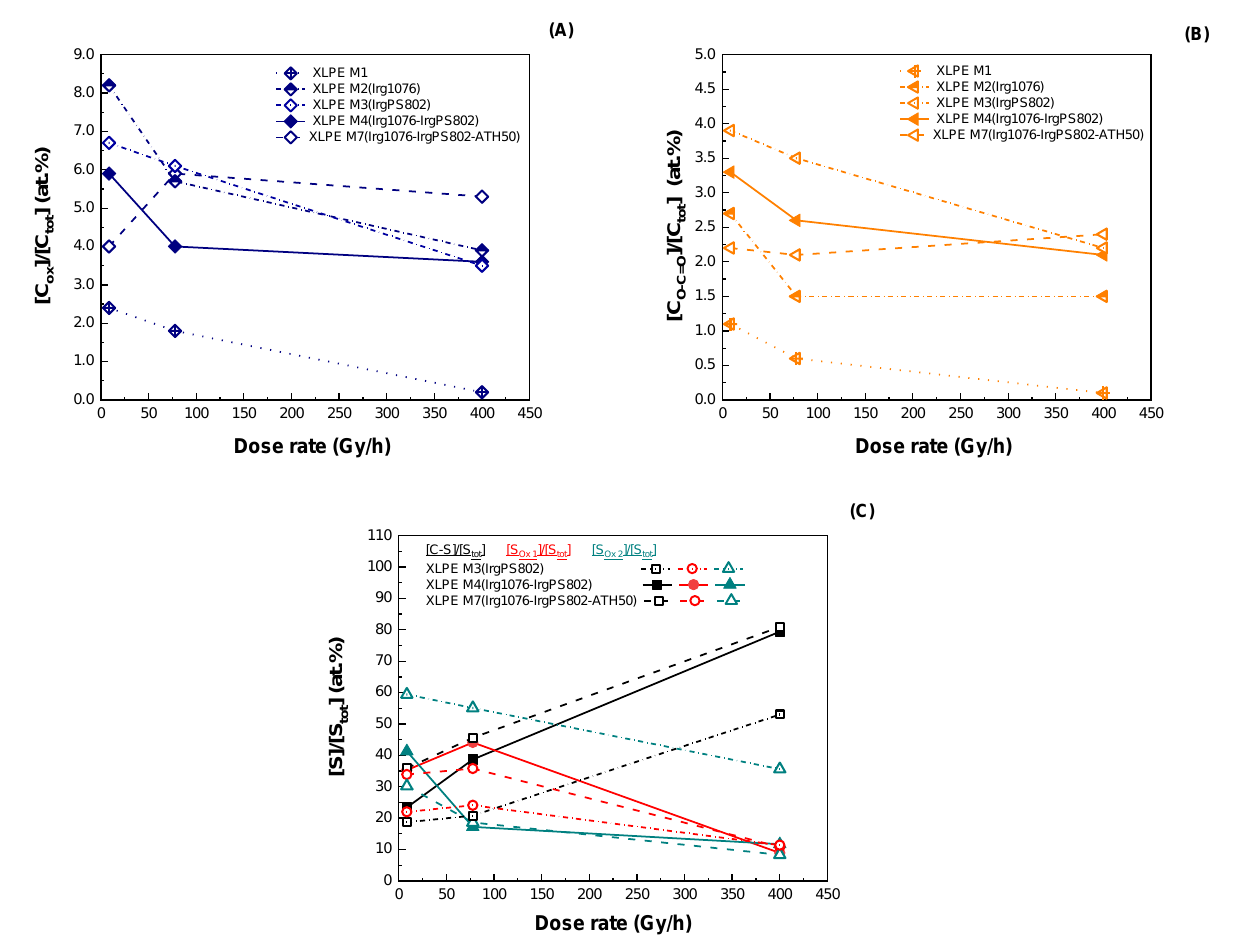
Figure 3. Evolution as a function of dose rate for XLPE M1, XLPE M2(Irg1076), XLPE M3(IrgPS802), XLPE M4(Irg1076-IrgPS802) and XLPE M7(Irg1076-IrgPS802-ATH50) of ( A ) C ox , which refers to all oxidised carbon atoms (i.e., O- C =O, C -O and C =O) and of ( B ) O- C =O. Evolution as a function of dose rate for XLPE M3(IrgPS802), XLPE M4(Irg1076-IrgPS802) and XLPE M7(Irg1076-IrgPS802-ATH50)